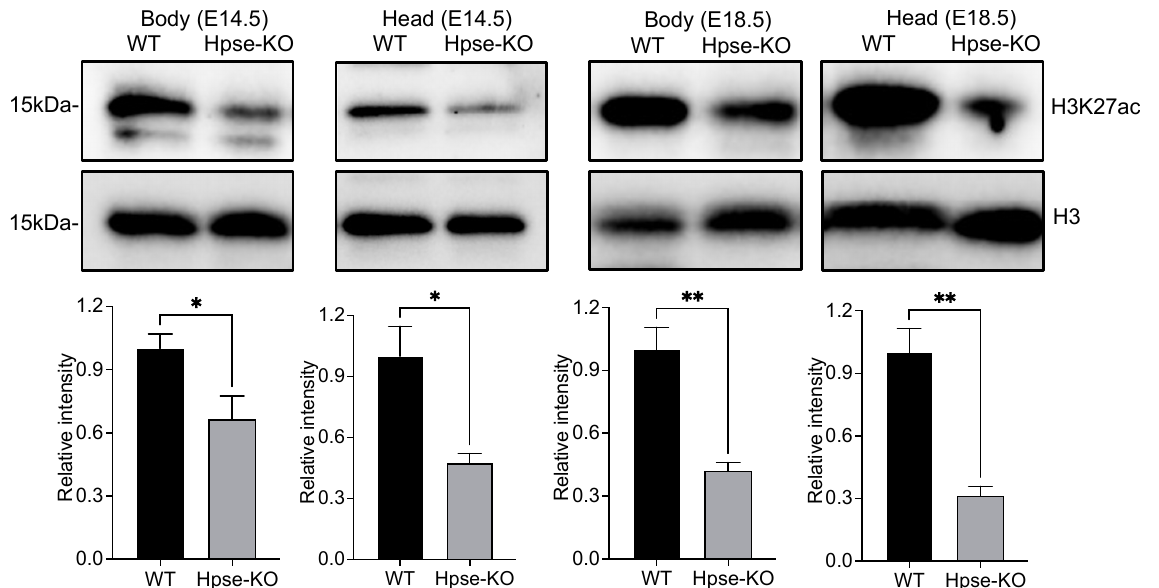
Figure 5. Western blot analysis of H3K27ac in embryos. Upper panels show representative blot from three experiments; lower panel shows relative intensity between WT and Hpse-KO. H3 represents internal control. The results are shown as the mean ± SEM of the band intensity. *: p < 0.05; **: p < 0.01.